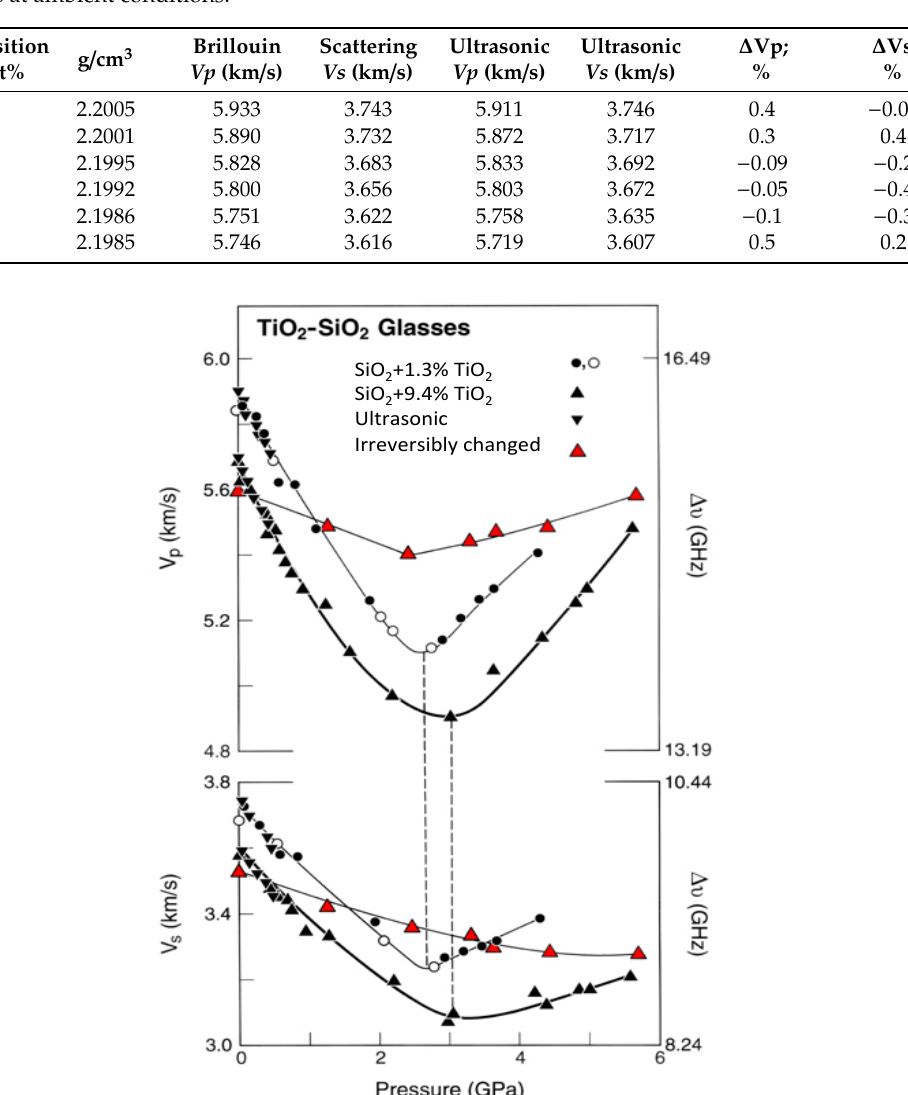
Table 3. Comparison of the ultrasonic and Brillouin scattering measurements of V p and V s in SiO 2 –TiO 2 glasses at ambient conditions.